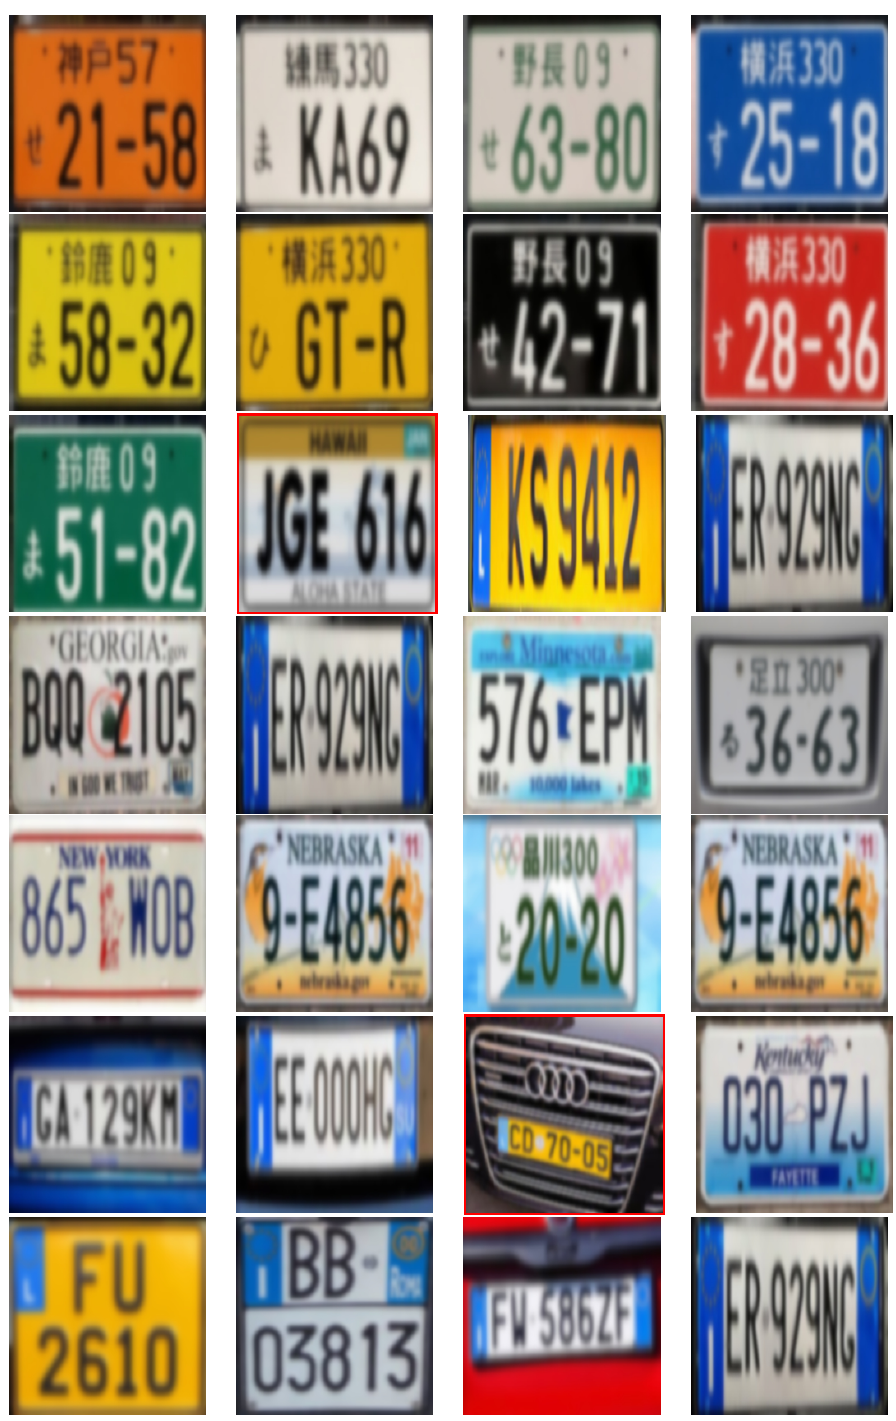
Figure 17. Twenty-eight test images (out of twenty-nine) used in the second comprehensive set of experiments. The colored images were turned grey-level by using the first channel of their RGB representation. (Two images marked by a red-color frame appear as outliers in the experiments described in the